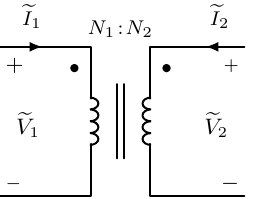
Figure 5. Ideal single-phase transformer model.